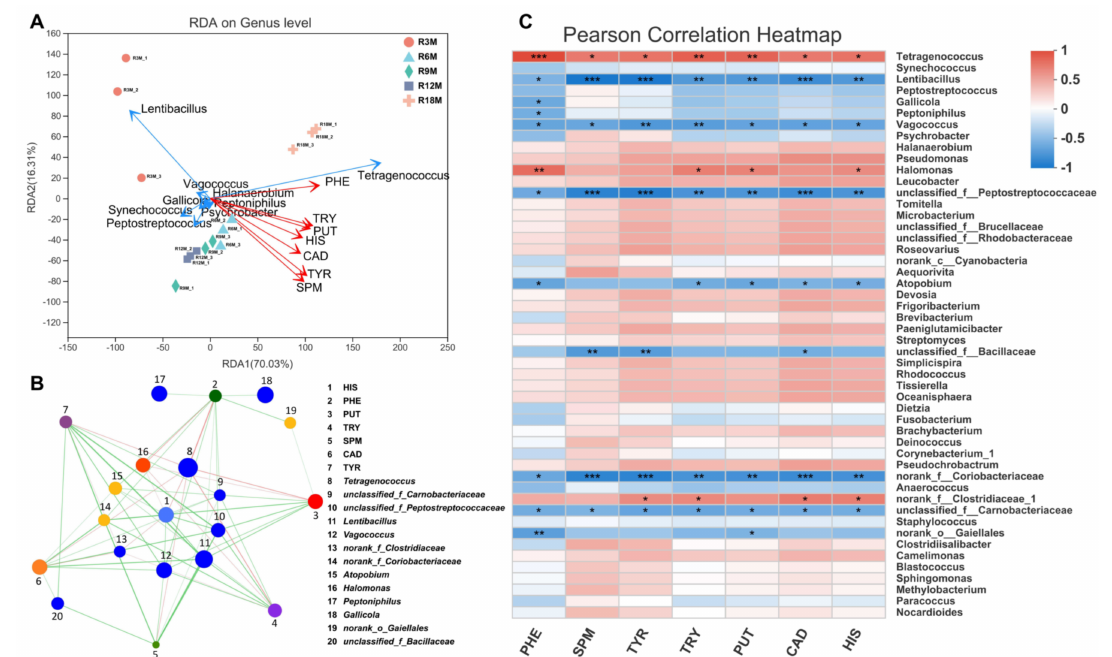
Figure 4. Correlation analysis between microorganisms and BAs during fish sauce fermentation. ( A ) RDA. Different samples are represented by points of different colors or shapes. The length of the arrows represents the degree of impact of environmental factors on the species data. The correlations are represented by the angle between the arrows (acute angle: positive correlation; obtuse angle: negative correlation; right angle: no correlation). ( B ) Correlation network analysis. The size of the nodes indicates the abundance of species, and different colors indicate different species. Red line: positive correlation, green line: negative correlation. ( C ) Pearson correlation heatmap diagram. * 0.01 < p ≤ 0.05, ** 0.001 < p ≤ 0.01, *** p ≤ 0.001. (R3M, R6M, R9M, R12M, R18M indicated for 3, 6, 9, 12, 18 months, respectively. TRY: tryptamine, TYR: tyramine, PHE: β − phenylethylamine, HIS: histamine, PUT: putrescine, CAD: cadaverine, SPM: spermine).